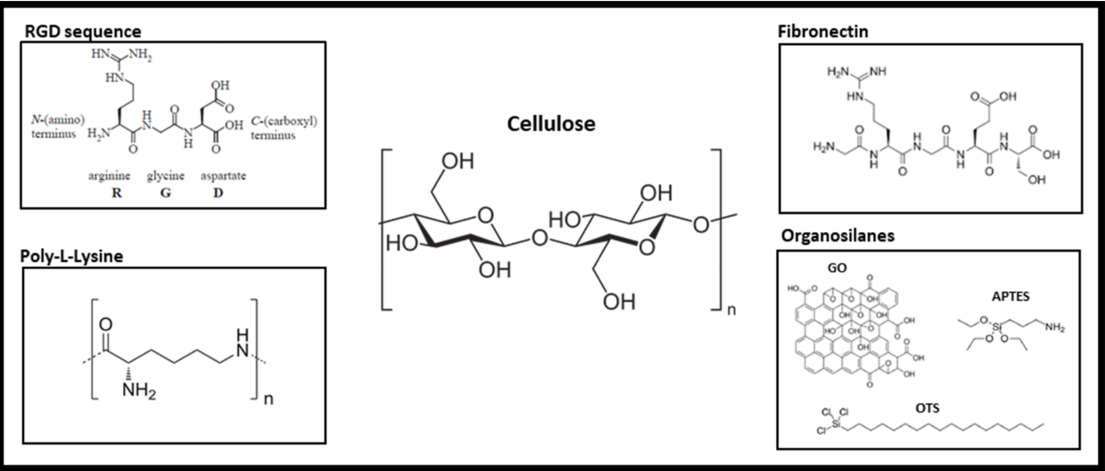
Figure 4. Commonly used biofunctionalization agents for promoting cell attachment to the hydroxyl groups of the cellulose-based